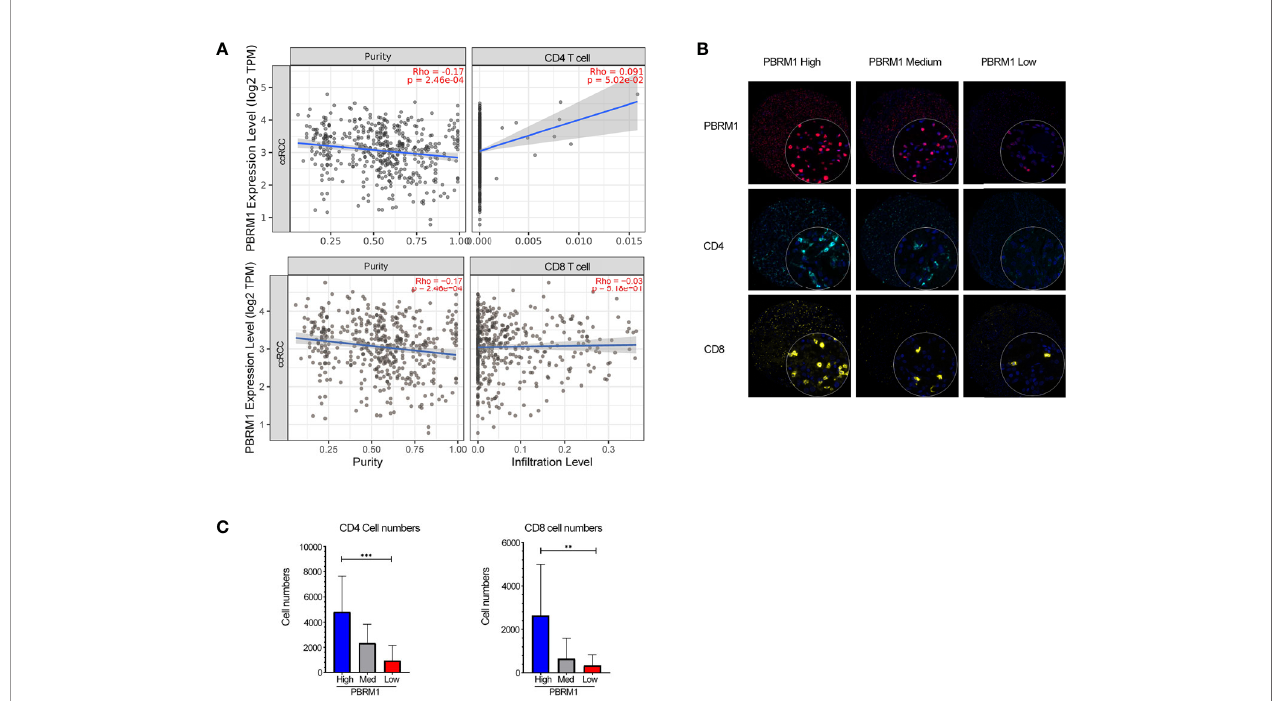
FIGURE 4 | Low expression of PBRM1 correlates with decreased CD4 cells in human ccRCC. (A) The correlation of PBRM1 expression with CD4, CD8 within tumors from 533 ccRCC patients were analyzed using the TIMER database. (B) Opal Multiplex Immunohistochemistry detection of PBRM1, CD4, CD8 in human ccRCC samples.180 ccRCC samples were tested and classi fi ed as High (>80%), Medium (50-60%), Low (<20%) according to the expression level of PBRM1 in the tumor tissues. (C) Represents the numbers of CD4, CD8 cells in (B) . PBRM1 High, PBRM1 Low groups were calculated by unpaired t-test,